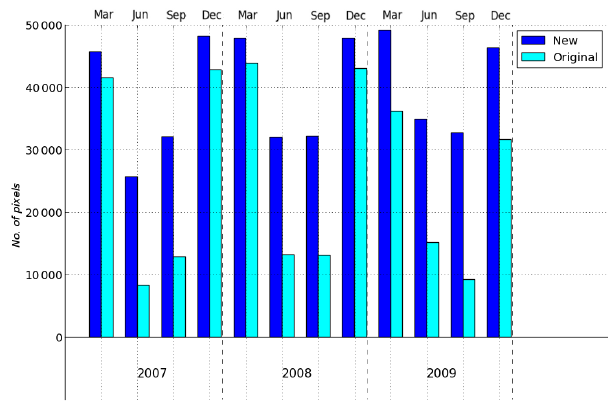
Figure 6. Monthly average number of pixels covered by each method for the test interval of 3 years.